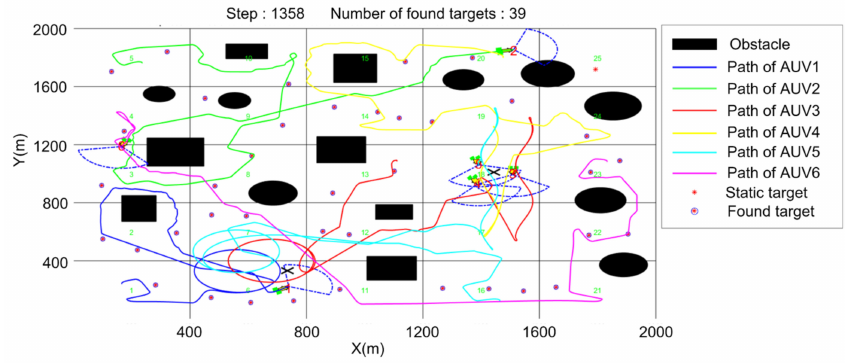
Figure 23. T = 1358 (steps).